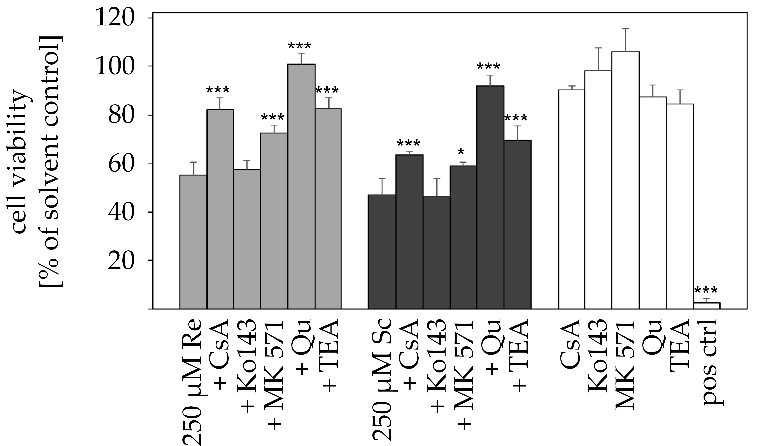
Figure 4. Effects of pharmacological influx and efflux inhibitors on retrorsine- and senecionine- induced cytotoxicity in differentiated HepaRG cells. HepaRG cells were pre-incubated for 1 h with the inhibitors CsA (10 µ M), Ko143 (5 µ M), MK-571 (50 µ M), Qu (100 µ M) or for 24 h with TEA (3 mM) before being incubated with 250 µ M retrorsine (bright gray bars) or senecionine (dark gray bars), respectively. Simultaneously, all inhibitors were incubated for 24 h as positive controls, respectively (white bars). Cell viability was assessed using the MTT assay and is displayed as percent of solvent control as mean + SD of three to thirteen independent experiments with five incubations each. 0.01% Triton X-100 was used as a positive control (pos ctrl), resulting in a decrease of cell viability below 5%. Statistical analysis was performed using one-way ANOVA, followed by Dunnett’s post-hoc test, and significant differences are depicted as follows: * p < 0.05, *** p < 0.001. Re, retrorsine; Sc, senecionine.